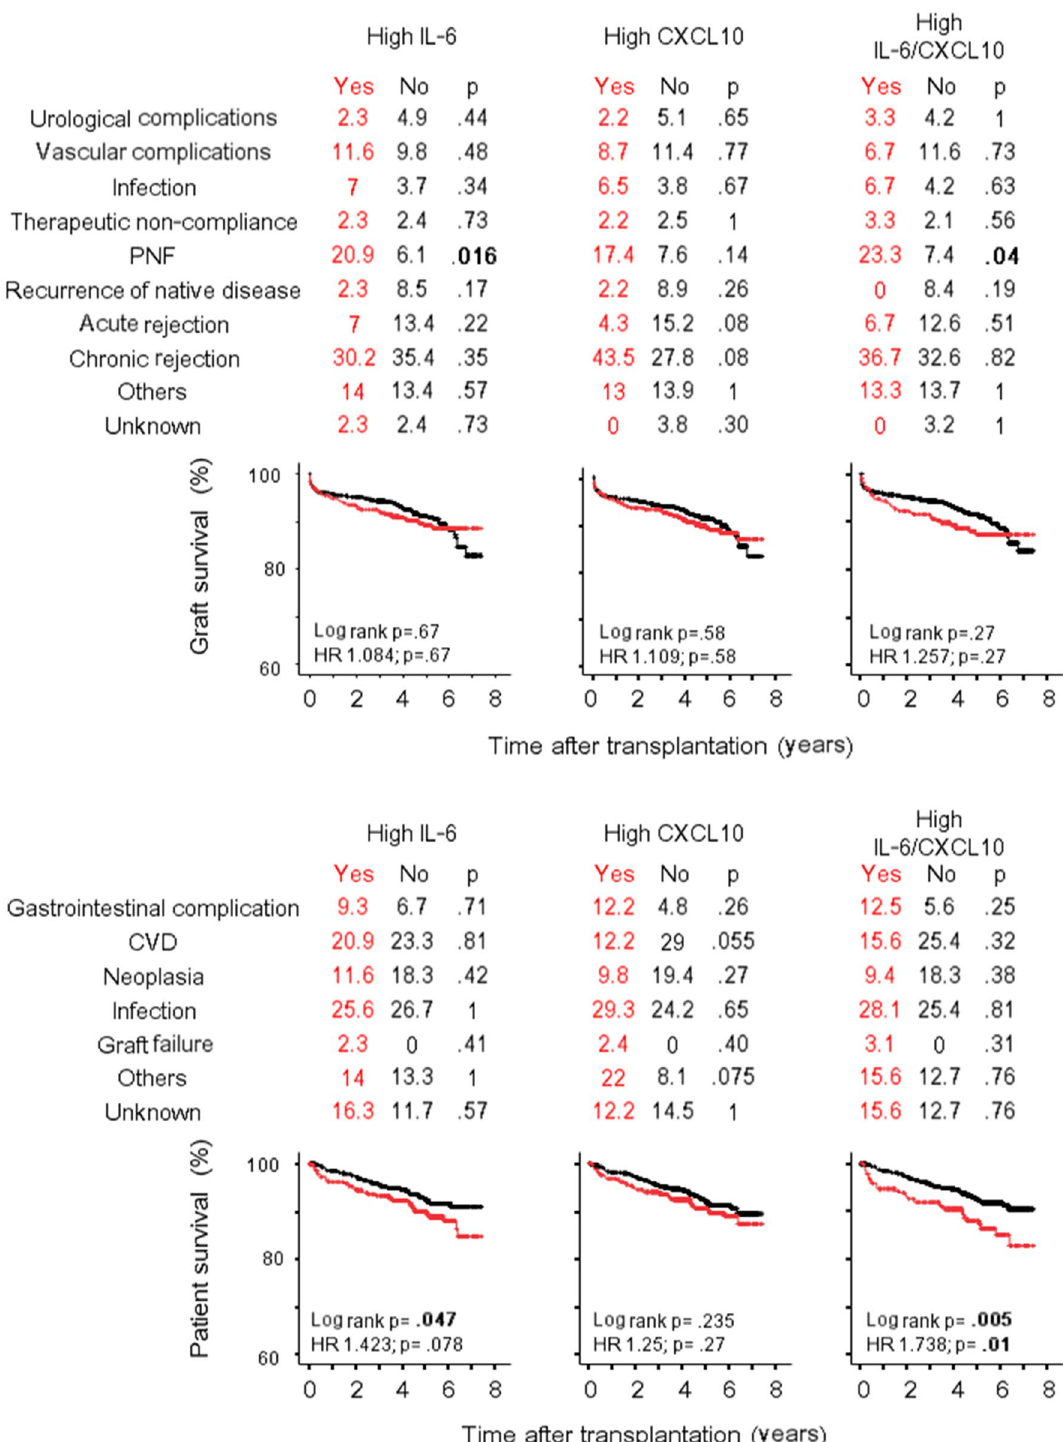
Figure 4. Graft and recipient survival after kidney transplantation. Causes of graft failure (%), causes of recipient death (%) and Kaplan–Meier graft and recipient survival curves after kidney transplant are represented according to high IL-6 and high CXCL10 categories. PNF primary non function, CVD cardiovascular